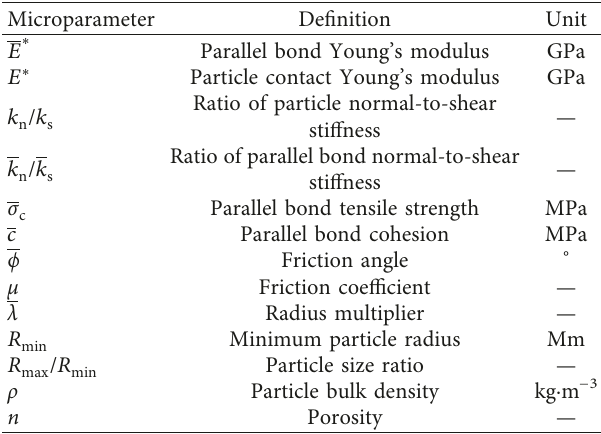
Figure 3: Numerical models for mechanical tests: (a) uniaxial compression; (b) triaxial compression; (c) Brazilian disc test. Table 1: Microparameters of the contact bond model and parallel bond